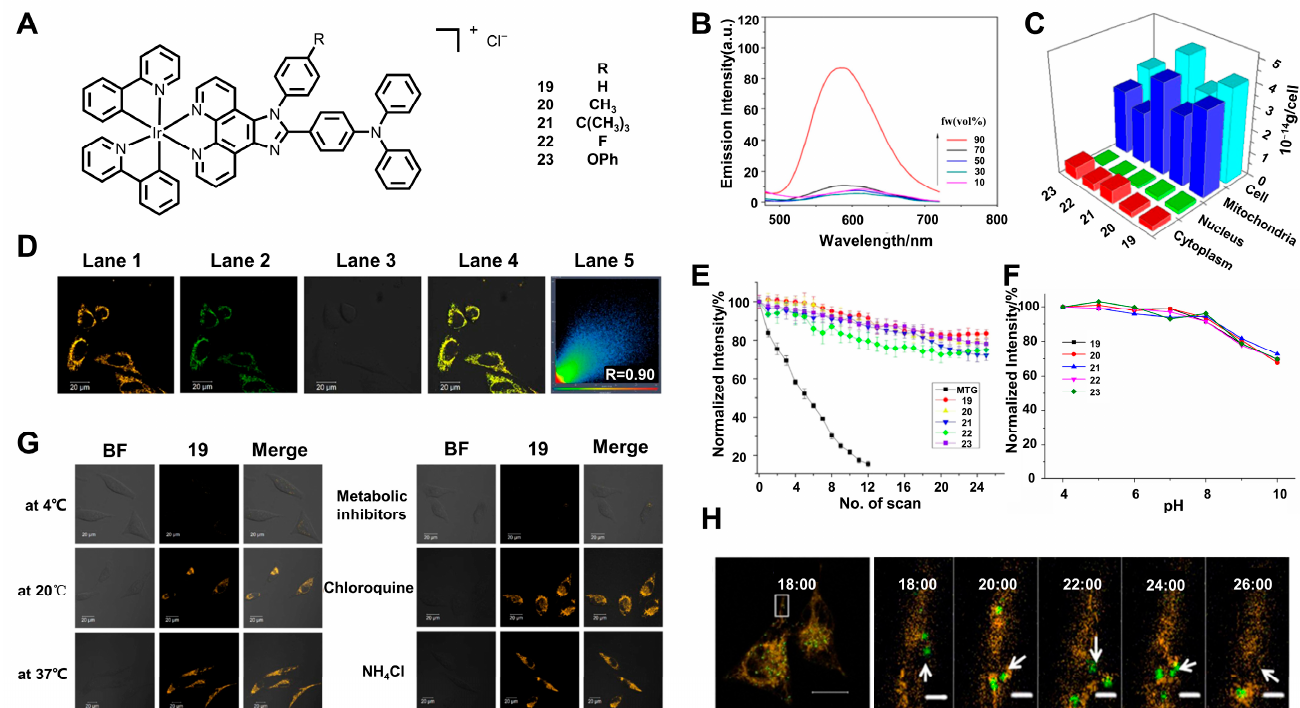
Figure 8. ( A ) Molecular structures of 19–23 complexes. ( B ) Emission spectra of 19 in DMSO-PBS mixtures with different water fractions. ( C ) Viability of HeLa cells incubated with 500 nM of 19–23 . ( D ) Confocal images of living HeLa cells incubated with 19 and their images. ( E ) Quantitative photobleaching results of 19–23 in HeLa cells. ( F ) Emission intensity of 10 µ M of 19–23 at 590 nm under different pH. ( G ) Confocal luminescence image and bright-field images of living HeLa cells incubated with 500 nM 19 in DMSO-PBS under different conditions. ( H ) Confocal images of HeLa cells stained with 19 (500 nM, orange) and LTG (100 nM, green) in the presence of CCCP (10 µ M). The regions (right) indicated in white boxes are enlarged from the shown area of this cell (left). The location that the white arrow pointed out indicated the occurrence of mitophagy. Reprinted with permission from [69], copyright 2016, Springer